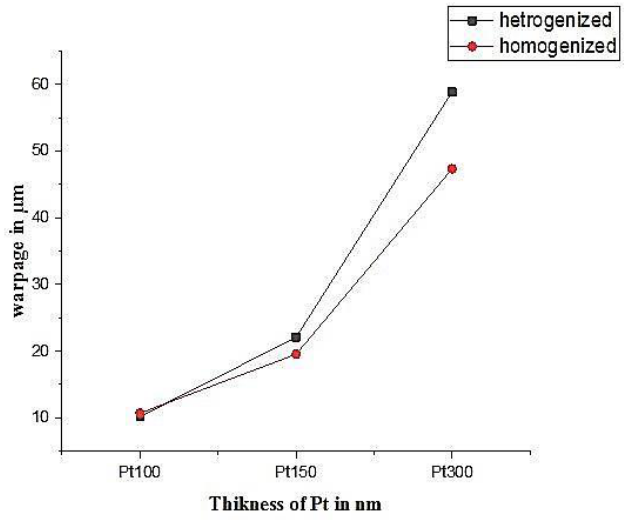
Figure 9. Warpage obtained using the homogenized/heterogeneous model.